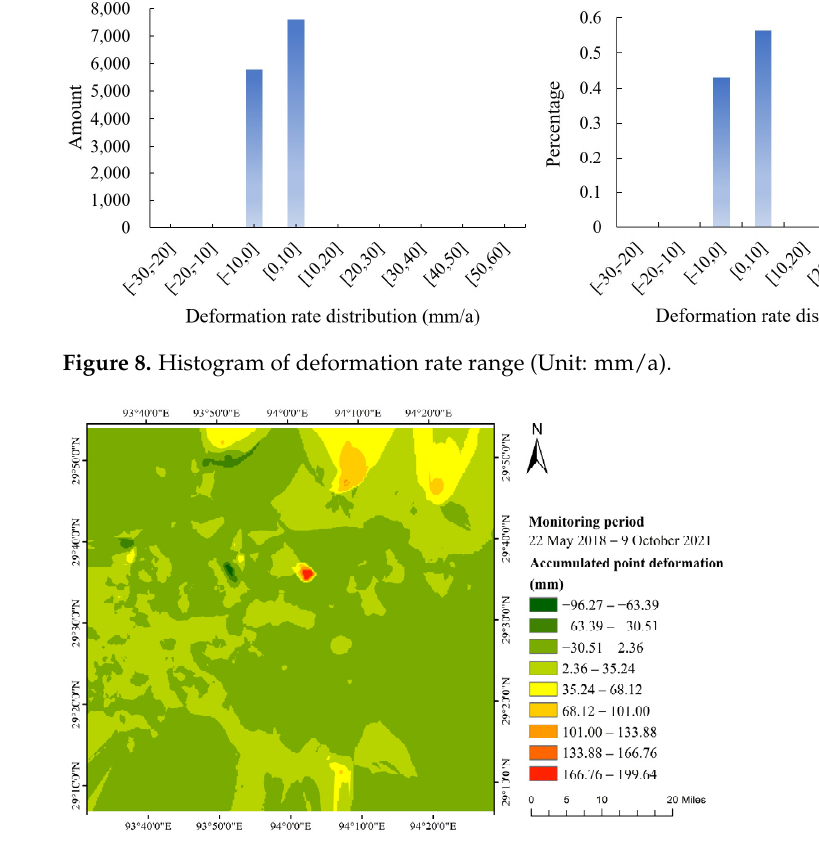
Figure 9. Ground point cumulative deformation diagram.